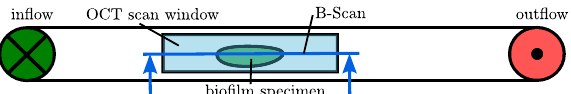
Fig. 16 Schematic setup of a flow cell experiment with biofilms for measurement with optical coherence tomography (OCT)